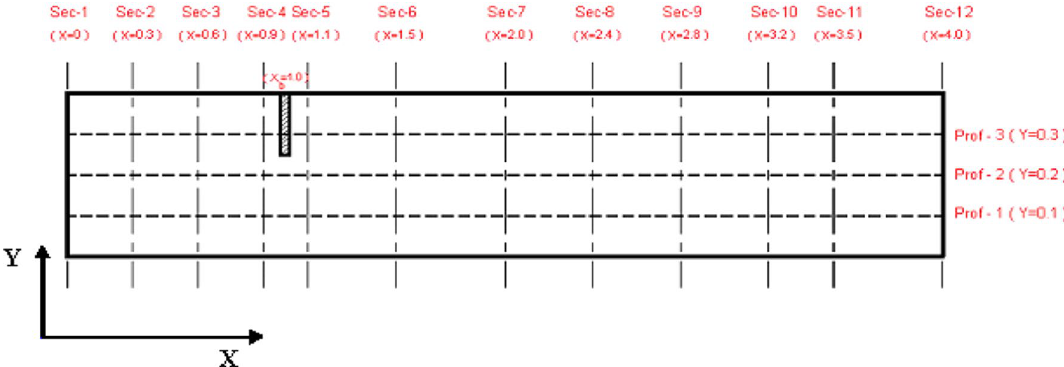
Fig. 6 The measured flow depths in longitudinal and cross